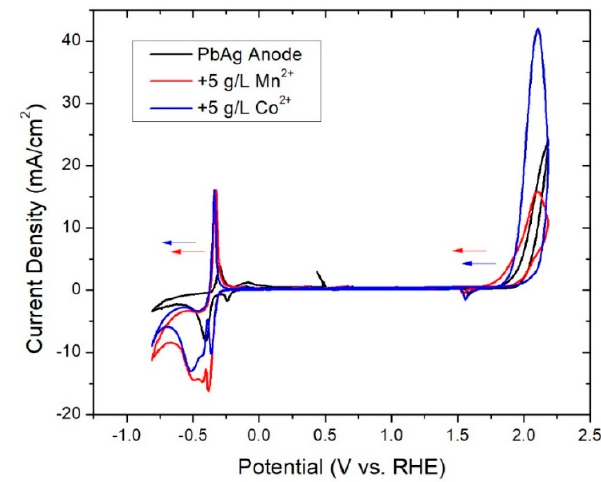
Figure 3. Cyclic voltammograms (scan rate 5 mV·s − 1 ) of the PbAg anode in 1.6 M H 2 SO 4 electrolyte, as seen in Figure 1, alongside identical samples that were subjected to the same electrolysis conditions with Co 2+ (blue) or Mn 2+ (red) ions in solution. Arrows indicate direction of redox feature shifts with additives present. Table 2. Quantification of cathodic shifts in CV features as catalytic metal additives are included in solution. The Pb/PbSO 4 redox couple represents a quasi-reversible process, while the others reported below are irreversible.